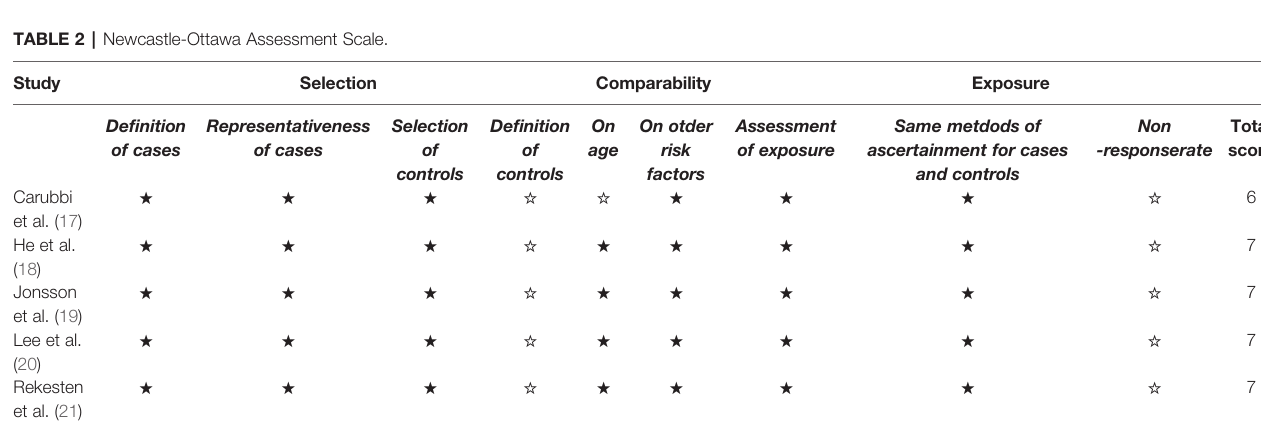
FIGURE 1 | PRISMA 2009 Flow Diagram.